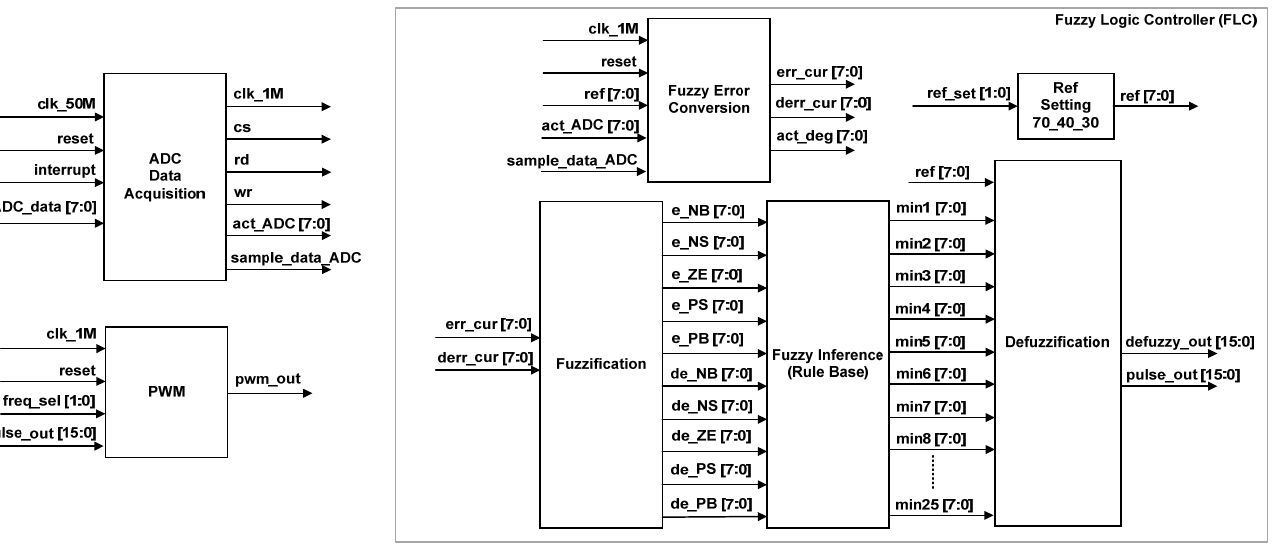
Figure 8. Internal architecture of the digital FFC.